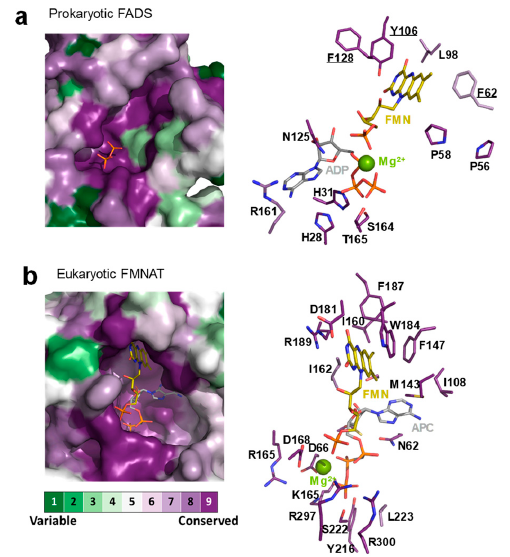
Figure 2. Sequence conservation at the FMNAT binding site in prokaryotic FADS and eukaryotic FMNAT families. Sequence conservation plotted on ( a ) Ca FADS (PDB 2x0k) and on ( b ) Cg FMNAT (PDB 3g5a) structures, showing active site for the FMNAT activity (left) and key residues for the binding of substrates / products highlighted as sticks (right). FMN and ATP:Mg 2 + substrates in (a) docked according to Reference [12]. The conservation plot was produced by the ConSurf server [31] and drawn with PyMol